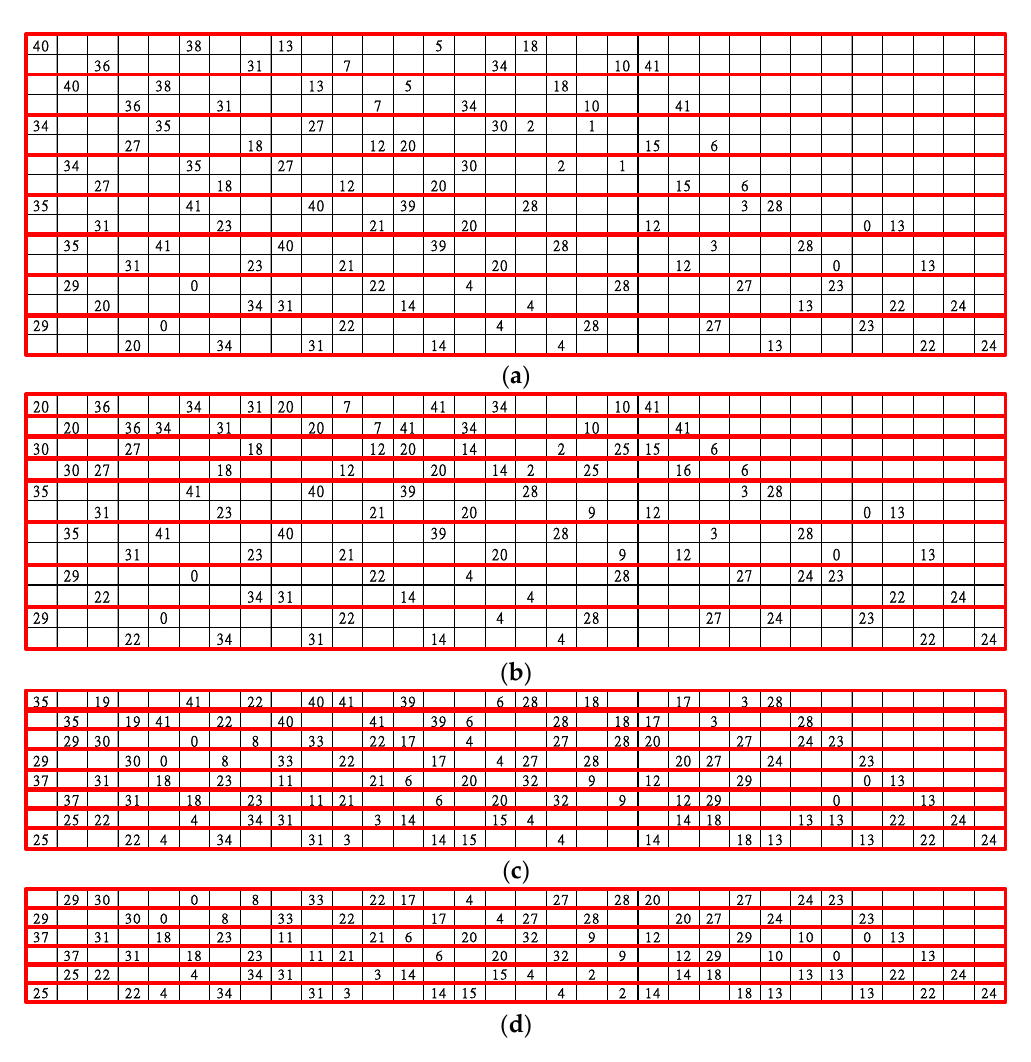
Figure 9. IEEE 802.11ay 2nd lifting matrix with R = ( a ) 1/2, ( b ) 5/8, ( c ) 3/4, and ( d ) 13/16.